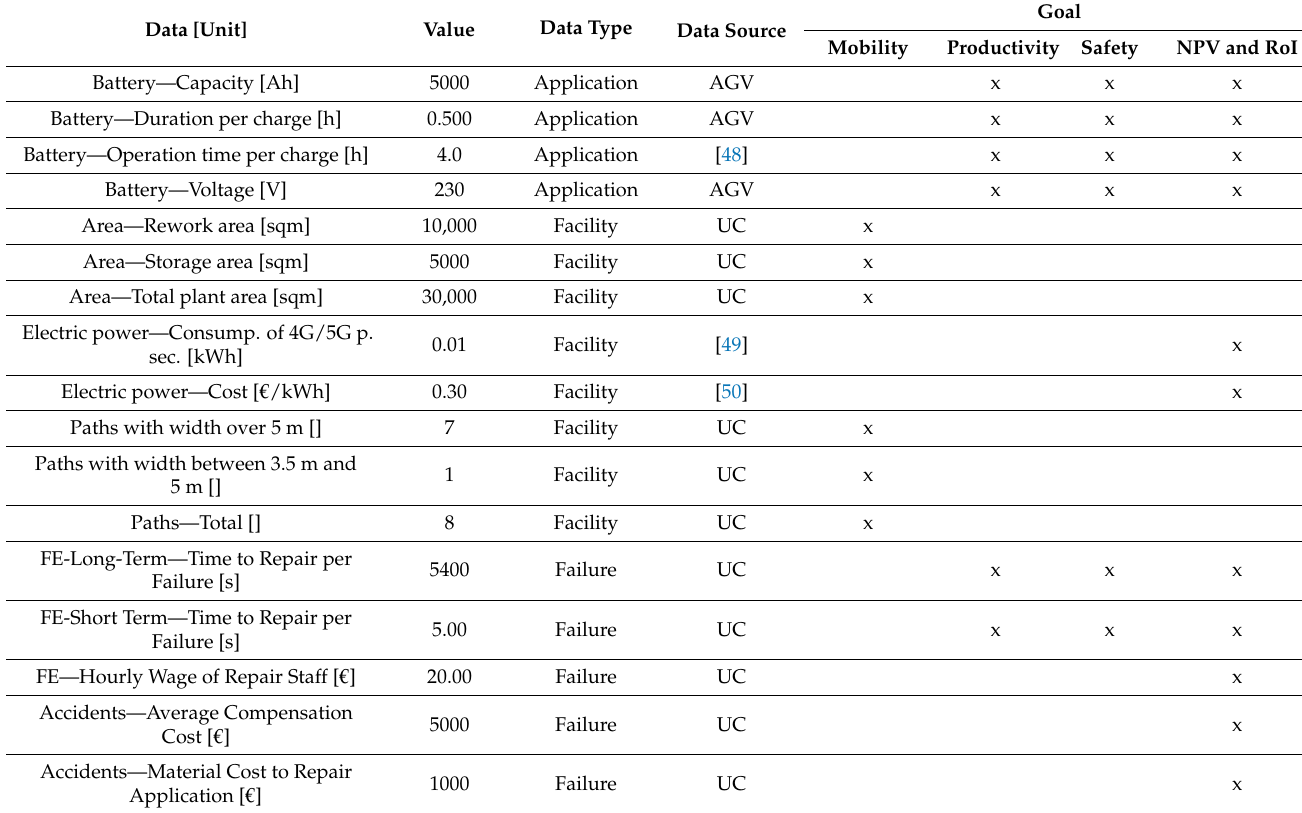
Table 3. Evaluation data for the AGV use